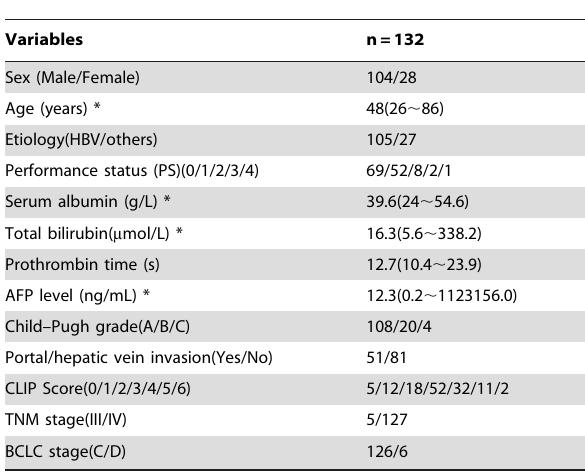
Table 1. Characteristics of HCC patients. Table 2. Site of extrahepatic metastases in 132 HCC patients with extrahepatic